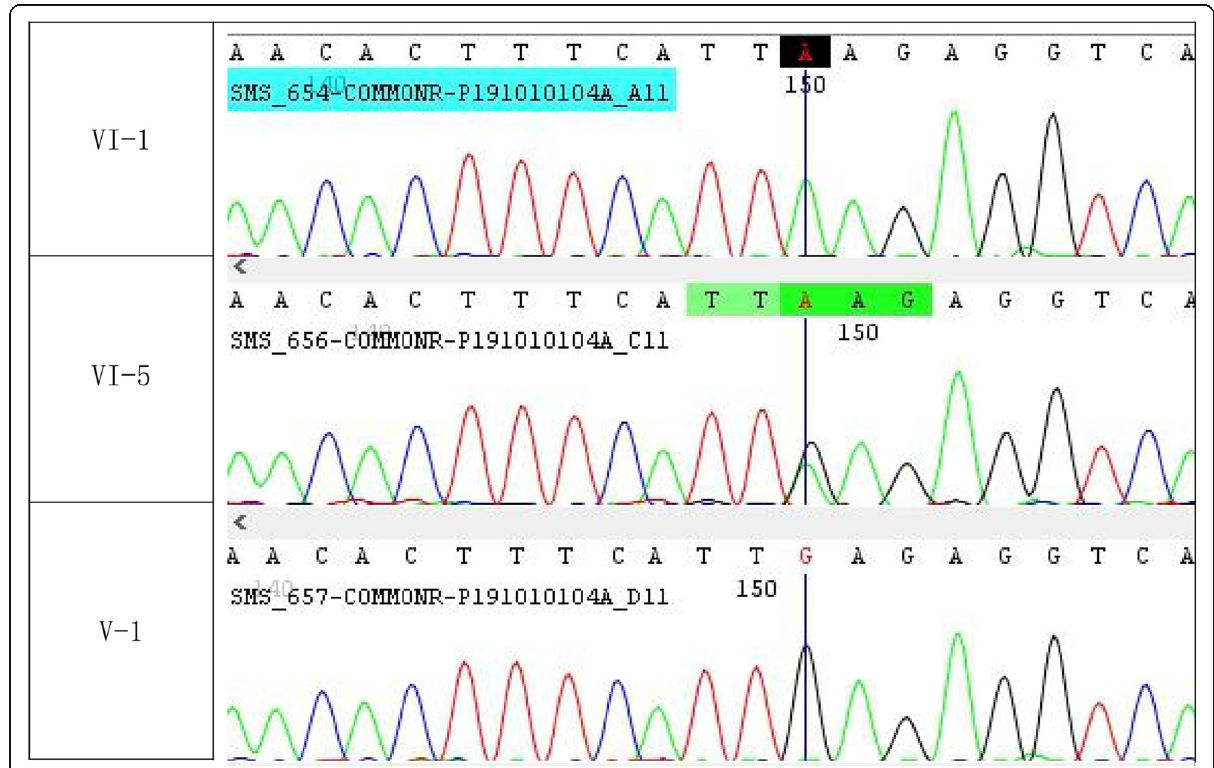
Fig. 2 Sequence chromatograms of the region including the variation c.905C > T in SMS gene of a normal individual (V:1), an obligate carrier (VI:5) and an affected individual (VI:1). A straight line indicates the position of variation on